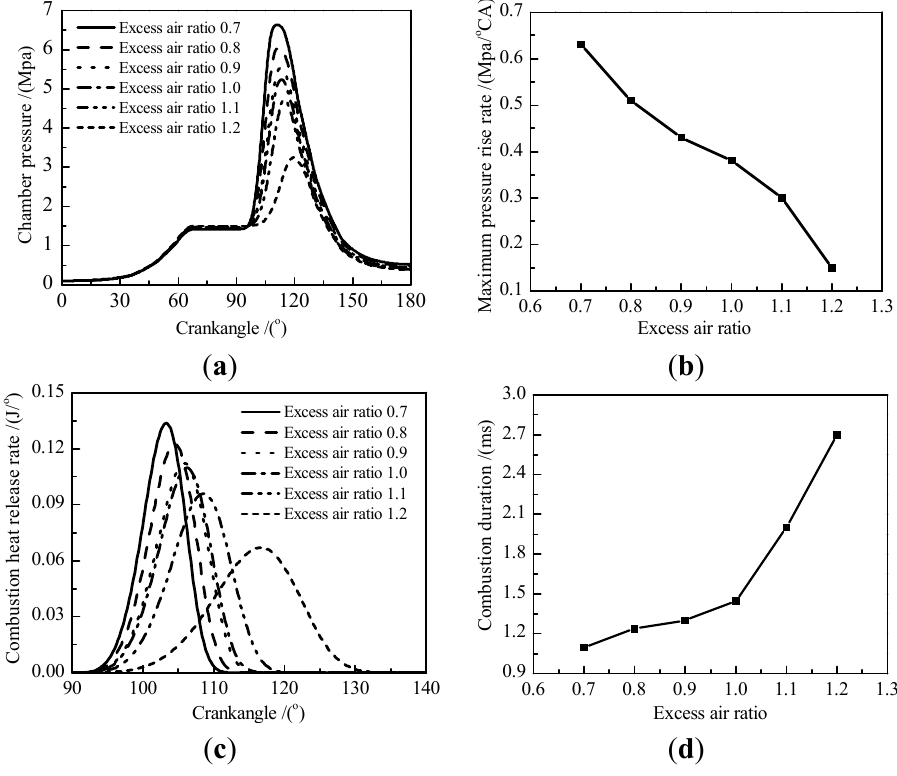
Figure 8. ( a ) Chamber pressure for excess air ratio; ( b ) Maximum pressure rise rate for excess air ratio; ( c ) Combustion heat release rate for excess air ratio; ( d ) Combustion duration for different excess air